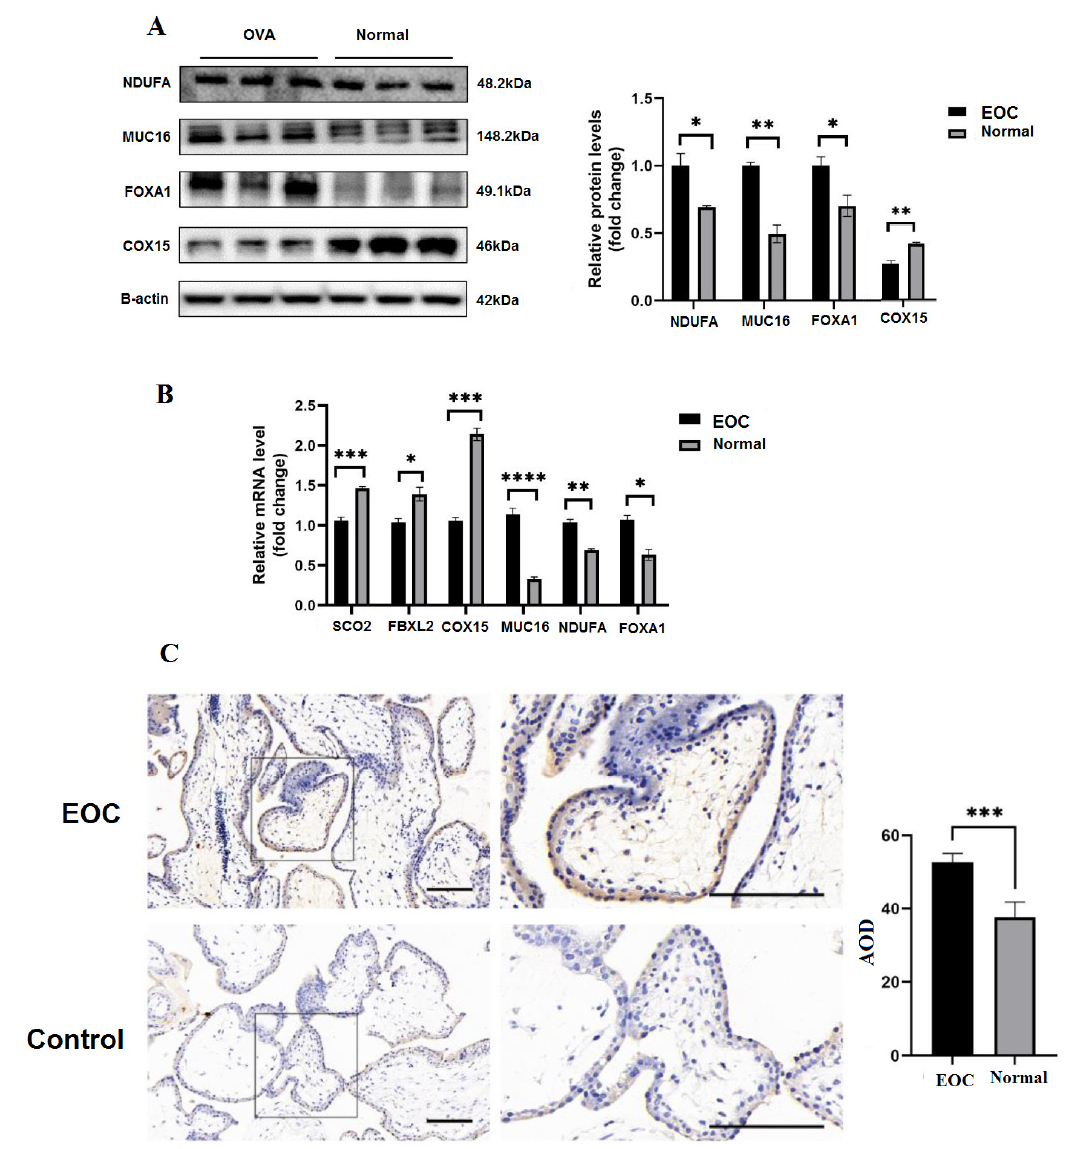
Figure 9. Dysregulated hub genes: ( A ) Western blotting showed alteration in the levels of MUC16, NDUFA, FOXA1, and COX15; ( B ) q-PCR assay was adopted to verify the changes of several hub genes; ( C ) IHC staining images of healthy samples and EOC samples and relative quantitative analysis in two groups; * p < 0.05, ** p < 0.01, *** p < 0.001, **** p < 0.0001.